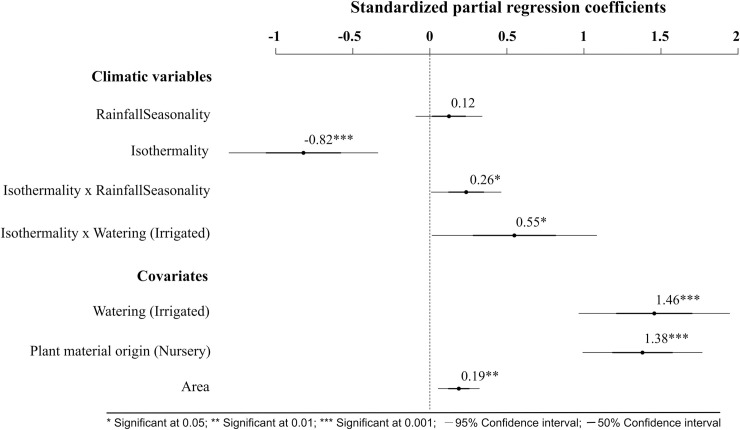
Effect size plot of the climatic variables and abiotic covariates influence on Verticillium dahliae occurrence according to the most plausible model (see Table 1).Effect sizes are shown on a cloglog scale. Rainfed and annual pruning were treated as reference levels for watering and plant material origin, respectively.